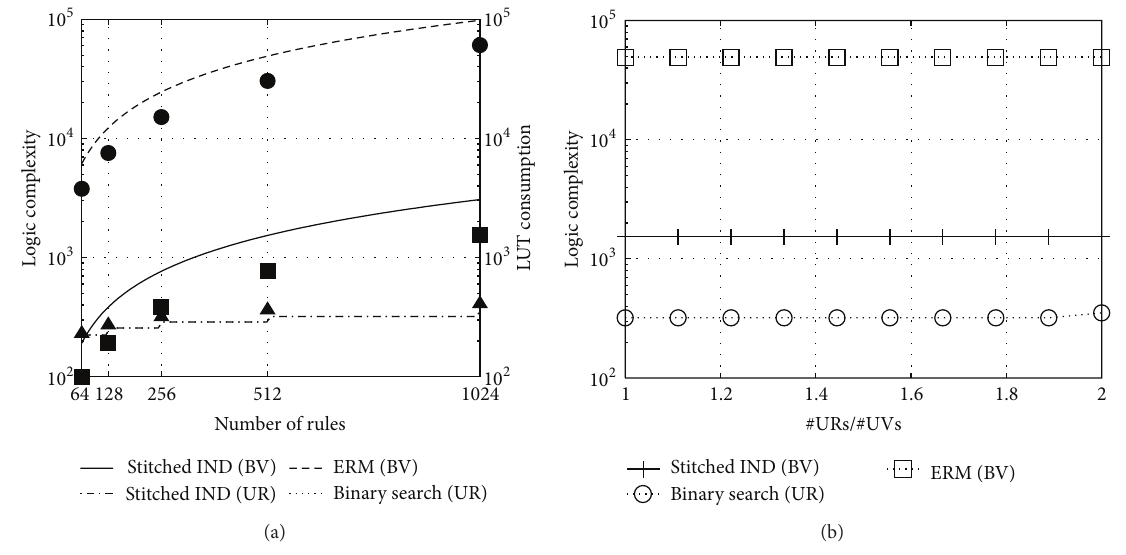
Figure 21: Logic complexity: (a) | UR | = | UV | = 𝑁 , 64 ≤ 𝑁 ≤ 1024 and (b) | UV | = 𝑁 = 512 , | UV | ≤ | UR | ≤ 2 ⋅ | UV |